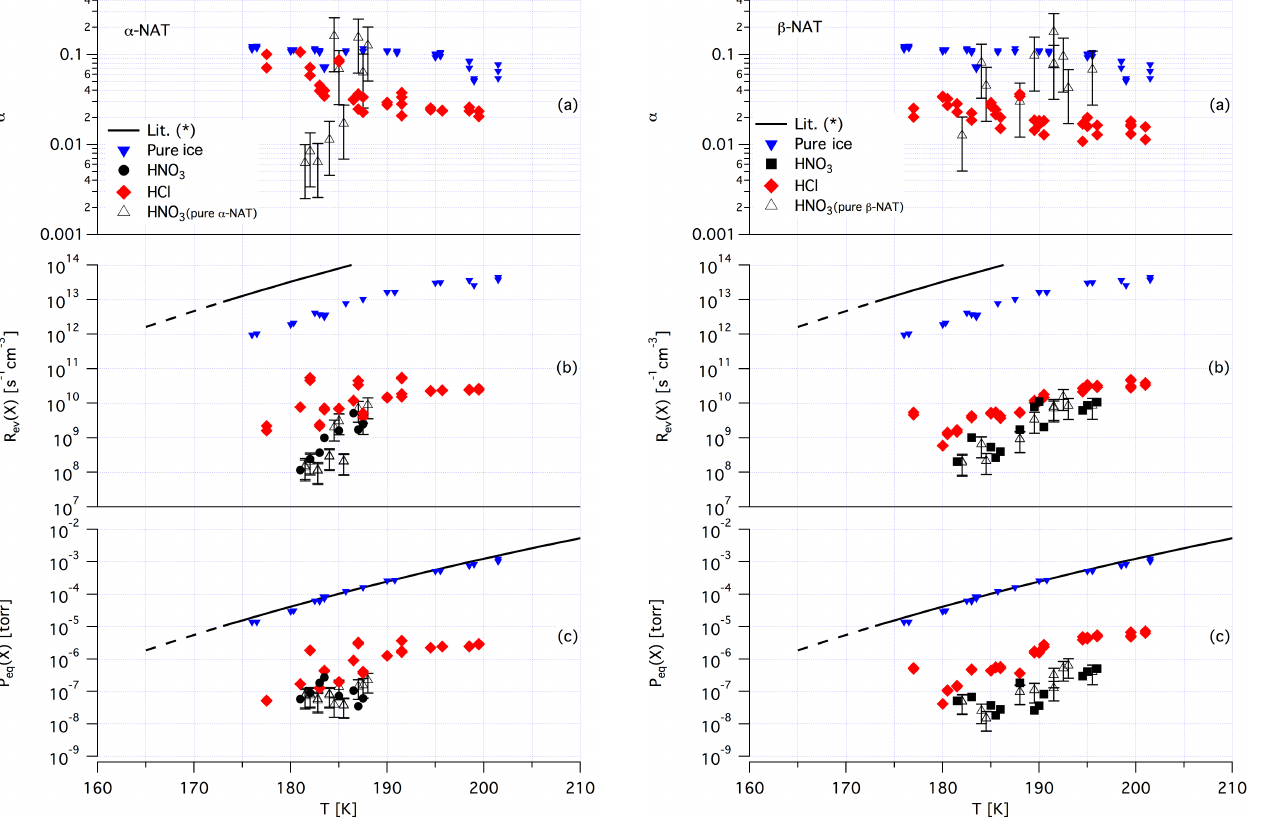
Figure 8. Synopsis of kinetic results for α -NAT using HCl as a probe gas in PV experiments. The symbols used are coded in the up- per panel. The calculated relative error for PV experiments is 30%. The black line shows results from Marti and Mauersberger (1993).